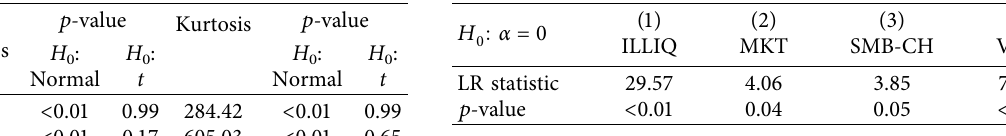
Table 4: Multivariate distributional tests. Table 5: Redundancy tests for the factors in